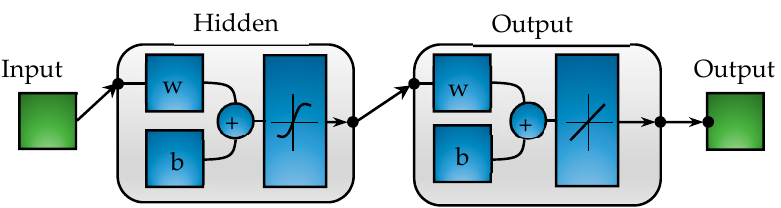
Figure 7. Feedforward neural network used in the paper.